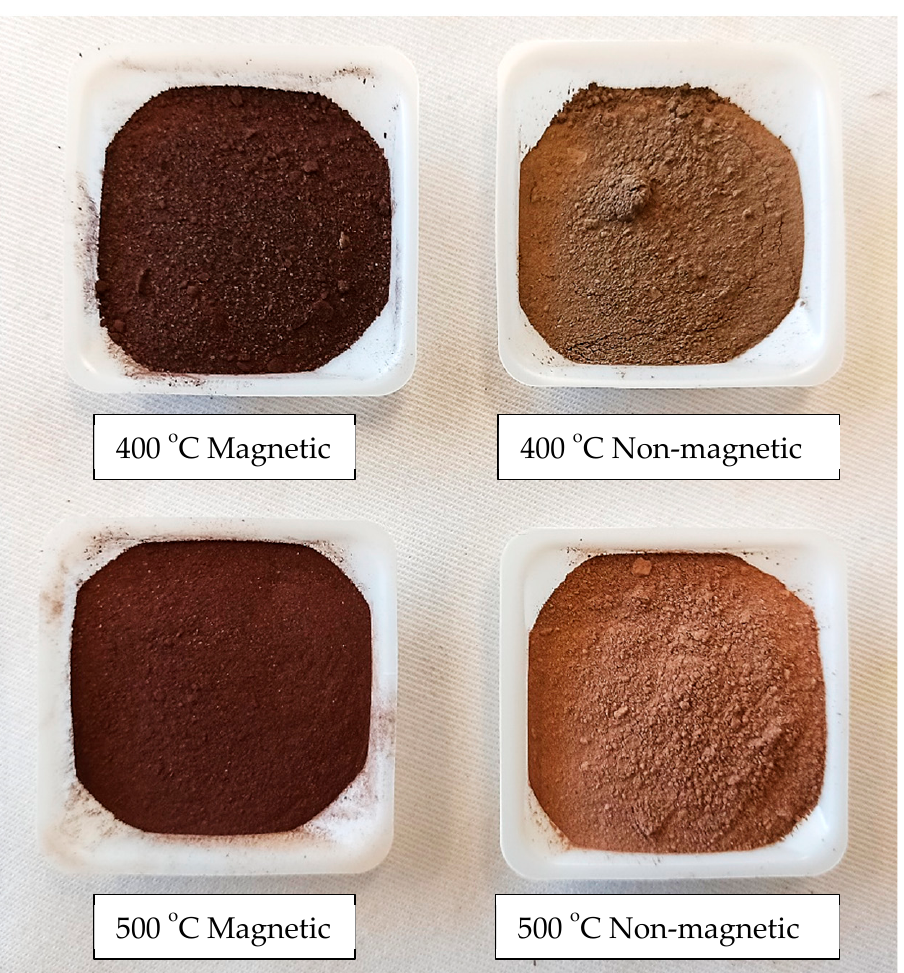
Figure 6. The collected magnetic and non-magnetic fractions obtained from the magnetic separation of Baker seam coal 2.20 SG sink fraction calcined at 400 °C and 500 °C. The XRD analysis of the magnetic fraction was performed to ascertain the phase changes in mineralogy because of calcination at 400 ◦ C and 500 ◦ C (Figure 7). The major minerals found in the magnetic fractions were quartz [SiO 2 ], kaolinite [Al 2 (Si 2 O 5 ) (OH) 4 ], and hematite [Fe 2 O 3 ]. As compared to the feed, the pyrite in the sample was transformed to hematite during the high-temperature calcination process in the presence of oxygen. Most of the iron-rich pyrite was converted to magnetic hematite and reported to the magnetic fraction. Moreover, the oxidation of pyrite aggregates associated with the compound particles in the feed resulted in the entrapment of quartz and kaolinite in the magnetic fraction due to incomplete liberation, resulting in a lower Fe grade. This observation is supported by the mass distribution percent data of other contaminants and REEs reported later in the investigation. Contrarily, a higher Fe grade at 600 ◦ C is likely due to the extraction of purely magnetic particles. It has been found previously that the change in the magnetic behavior of pyrite during thermal decomposition and oxidation is very complex and depends on factors such as temperature, oxygen concentration, and particle size